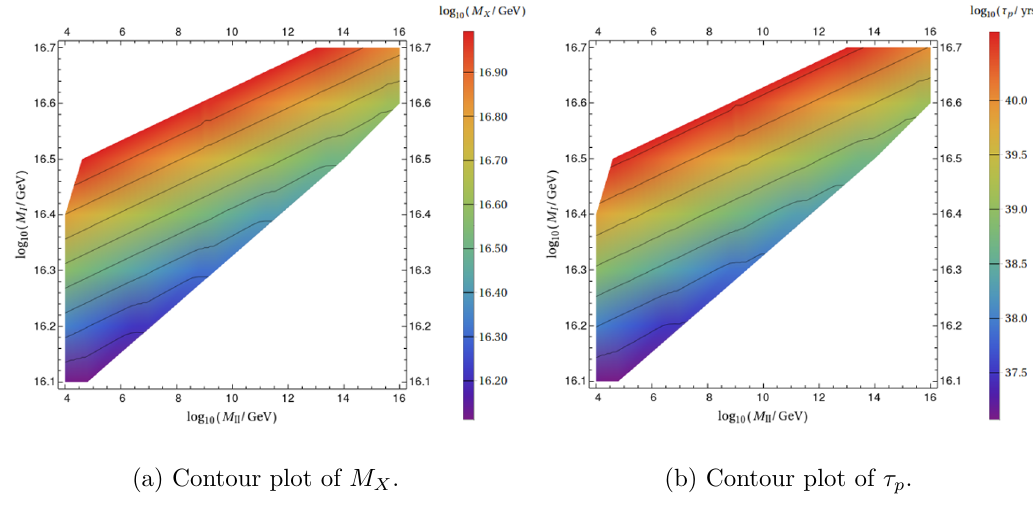
JHEP02(2021)114